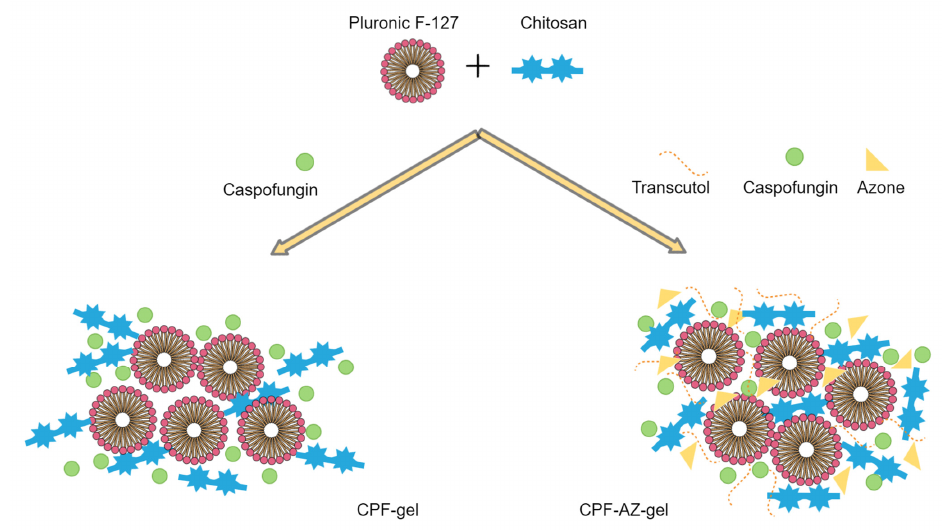
Figure 4. Schematic illustration of the mechanism of hydrogel formation.